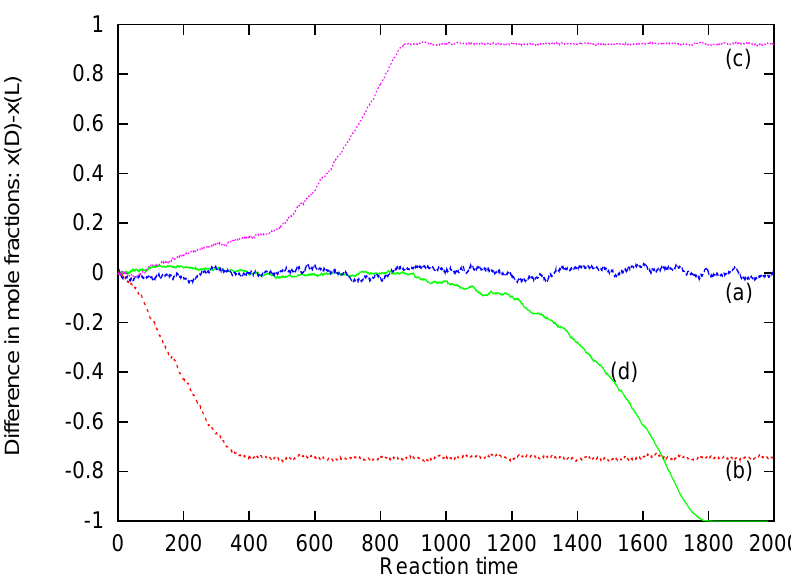
Figure 1. Difference in particle fraction, as a function of time in a molecular dynamics system with isomerization kinetics and for different strength of chiral discrimination, ac- H j = RT , (b) 2 RT , (c) 3 RT and (d) 1 cordingly to Eq.(4): (a) j ∆ cd